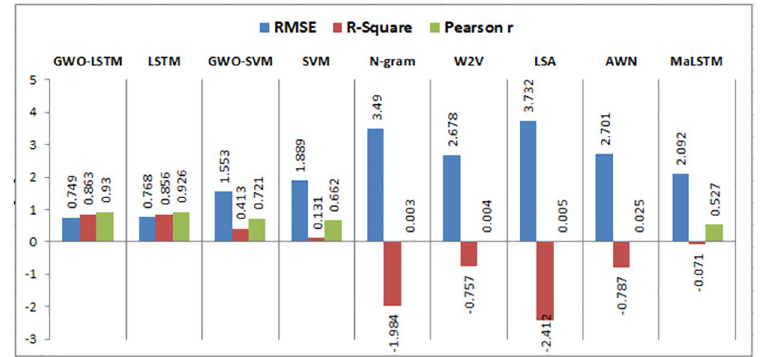
Fig 29. LSTM-GWO performance evaluation with experiment